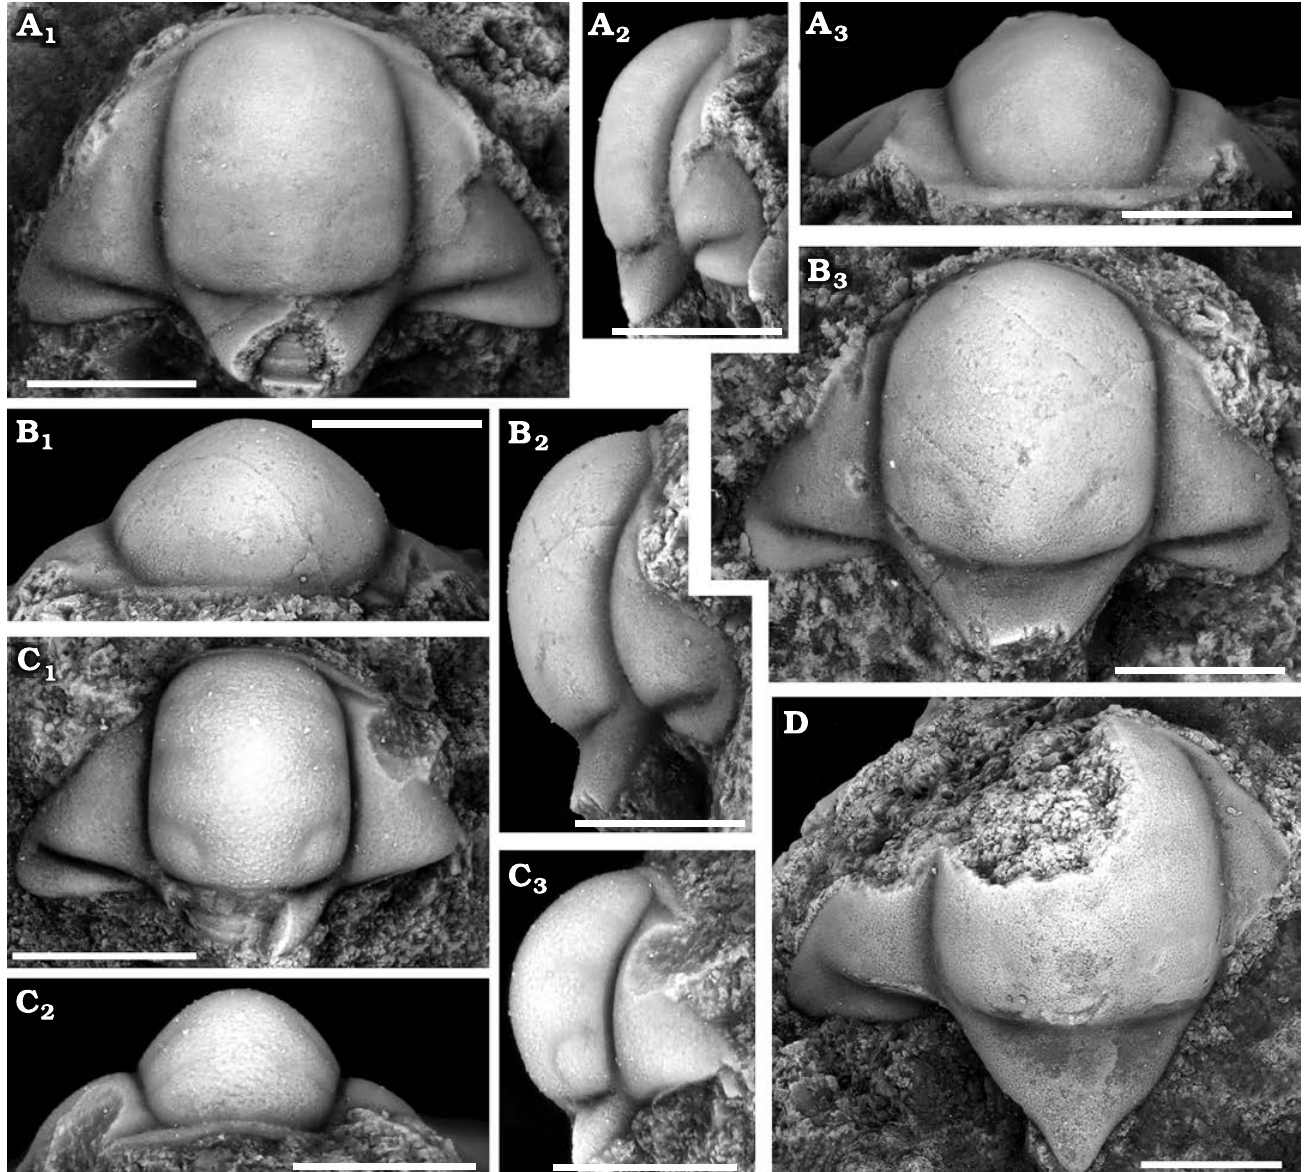
Fig. 2. Cranidia of catillicephalid trilobite Catillicephala cifellii sp. nov. from the Downes Point Member, Shallow Bay Formation, Guzhangian, Miaolingian, Cambrian; boulders BPS 468 (A), BPS 467 (B, D), BPS 458 (C), Broom Point South, western Newfoundland, Canada. A . GSC 142516, paratype; dorsal (A 1 ), lateral (A 2 ), and anterior (A 3 ) views. B . GSC 142517, paratype; anterior (B 1 ), lateral (B 2 ), and dorsal (B 3 ) views. C . GSC 142518, paratype; dorsal (C 1 ), anterior (C 2 ), and lateral (C 3 ) views. D . GSC 142519, paratype; dorsal view. Scale bars 1 mm. Fig. 3. Pygidia of catillicephalid trilobite Catillicephala cifellii sp. nov. from the Downes Point Member, Shallow Bay Formation, Guzhangian, Miaolingian, Cambrian; boulder BPS 467, Broom Point South, western Newfoundland, Canada. A . GSC 142520, paratype; dorsal (A 1 ), lateral (A 2 ), and posterior (A 3 ) views. B . GSC 142521, paratype; posterior (B 1 ), dorsal (B 2 ), and lateral (B 3 ) views. C . GSC 142522, paratype; posterior (C 1 ) and dorsal (C 2 ) views. D . GSC 142523, paratype; posterior (D 1 ) and dorsal (D 2 ) views. E . GSC 142524, paratype; dorsal view. Scale bars 1